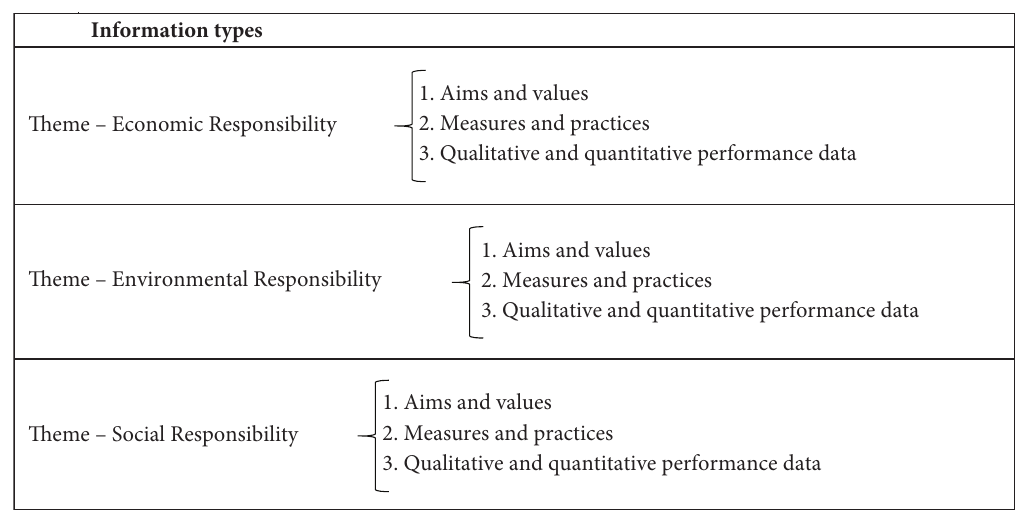
Figure 2. Coding system – Quality of information based on Vuontisjärvi